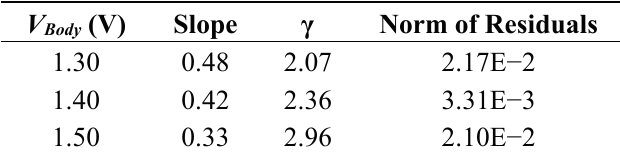
Table 1. Simulation results of V Body , slope and norm of residuals.